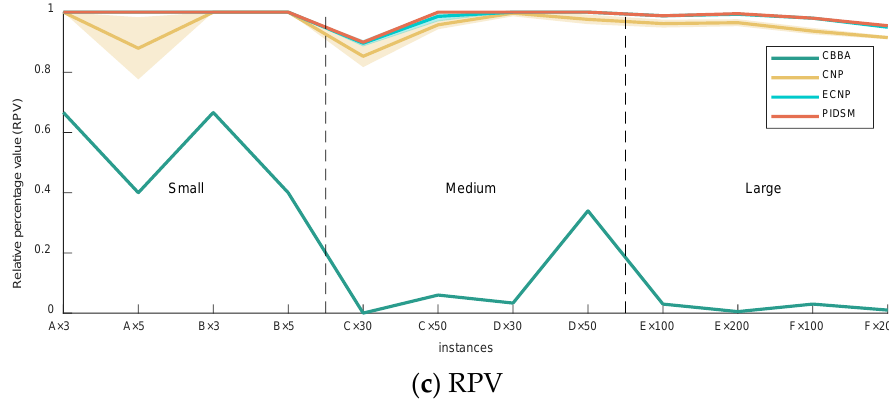
Figure 6. Variation trend of δ , RPV , and φ for each algorithm on different instance types.